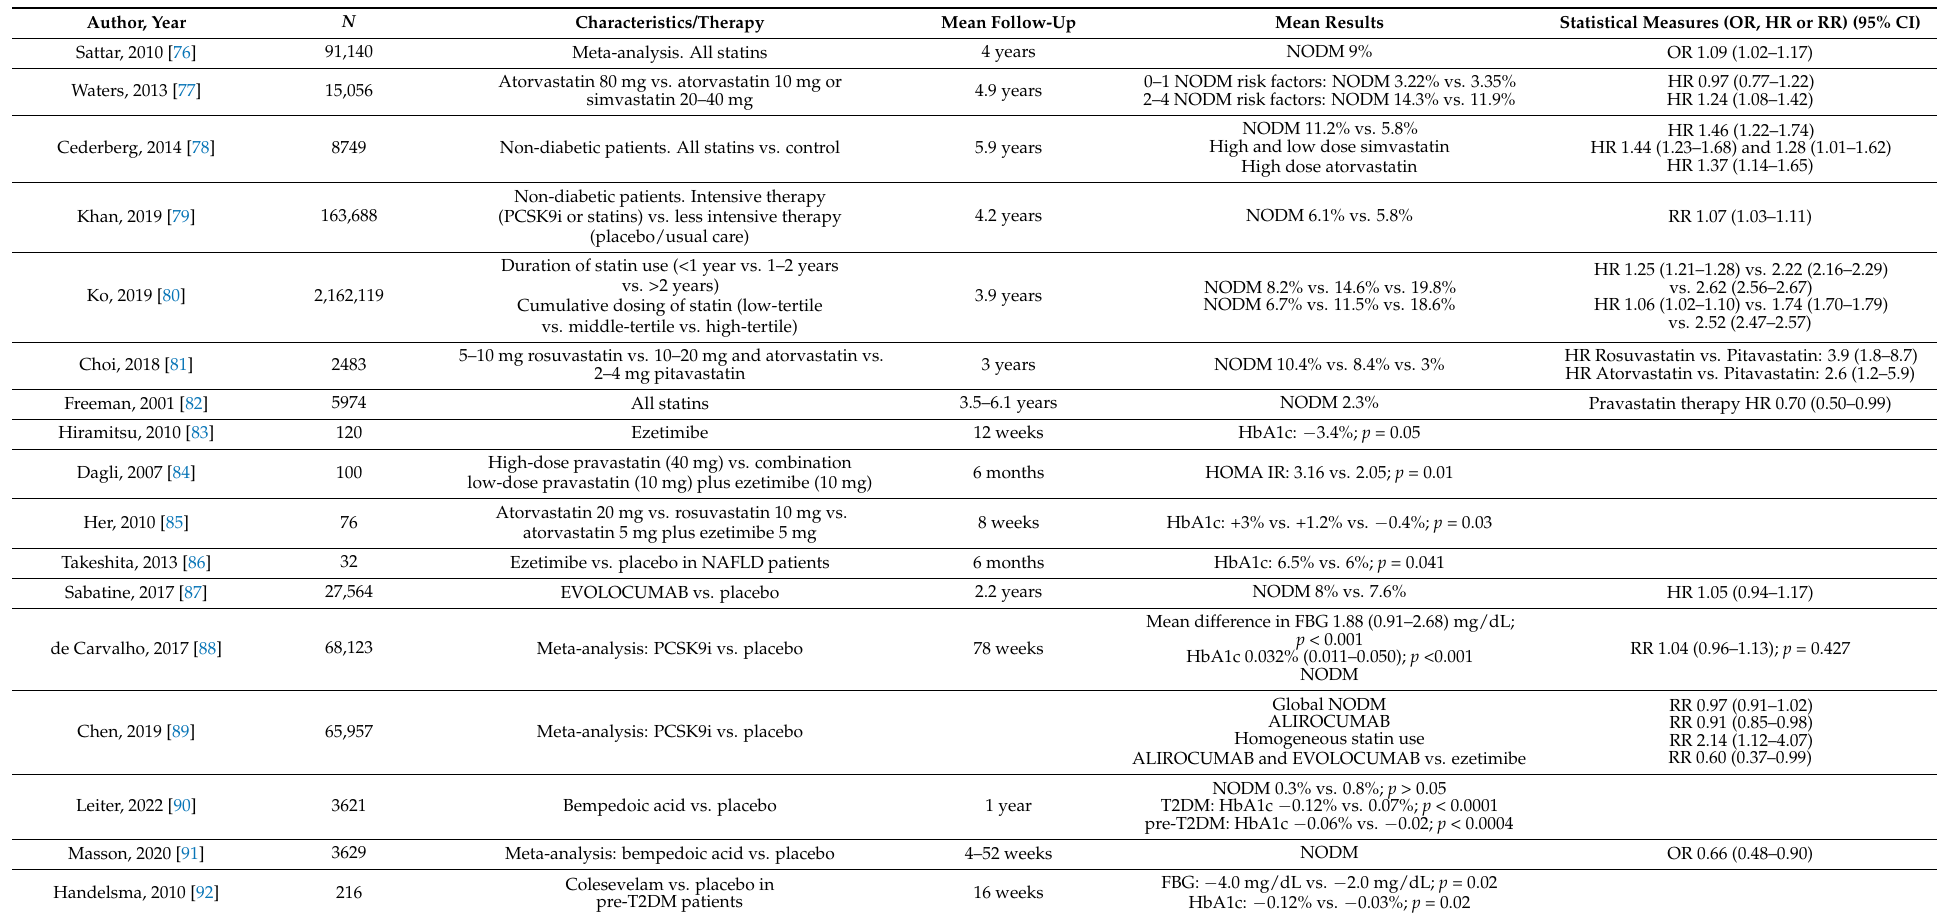
Table 2. Studies assessing the association between lipid-lowering drugs and disorders of glucose